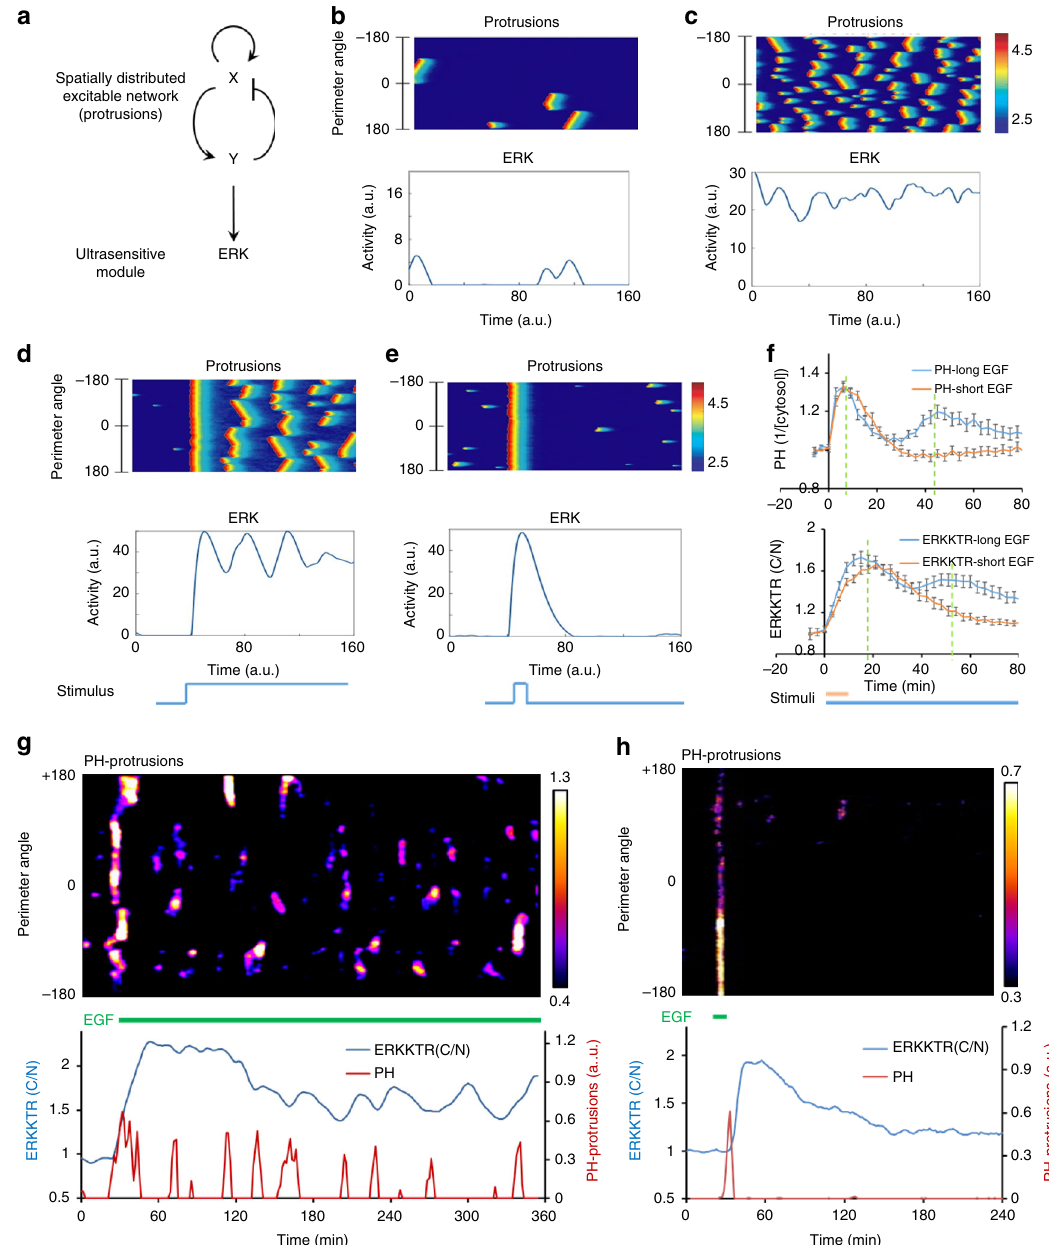
Fig. 5 Computational simulation and experimental validation of the model. a Schematic of a spatially distributed protrusive excitable network (EN) coupled to an ultrasensitive ERK module. b , c Simulated kymographs of protrusions along the perimeter of a circular cell (upper) driving ERK activation (lower). A high threshold for EN caused infrequent protrusions with discrete ERK pulses ( b ), whereas a low threshold led to frequent protrusions and continuous ERK activation ( c ). d , e Simulated kymograph of protrusions and ERK activation in response to a long ( d ) and short ( e ) stimulus. f Responses of PH-AKT (upper) and ERKKTR (lower) to long (20 ng/ml of EGF at 0 min) and transient (20 ng/ml of EGF at 0 min followed by 1 µ M ge fi tinib at 9 min) stimuli in MCF7. Values are mean ± s.e.m., with normalization to pre-stimulus levels; n = 20 (short) and 22 (long) cells for PH-AKT; 31 (short) and 57 (long) cells for ERKKTR. g , h (Upper) Kymographs of PH-AKT-enriched protrusions (color scale: intensity (A.U.) identi fi ed by FDM, see Methods) around the cell perimeter in response to a long ( g ) and short ( h ) EGF stimulation. (Lower) Plot of integrated intensity of protrusions and C/N ratio of